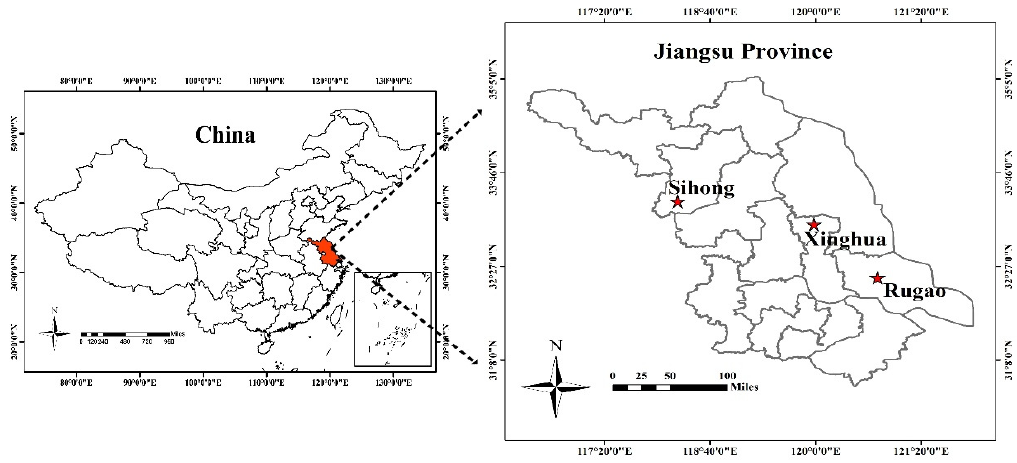
Figure 1. Study sites: wheat experiments were performed at Rugao, Sihong and Xinghua Experimental Stations in the Jiangsu province of China.